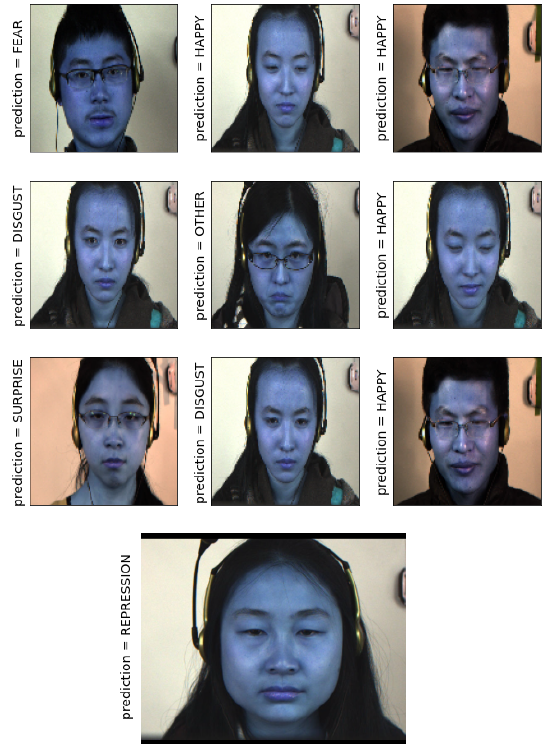
Figure 12. LARNet prediction on CASME II dataset (uncropped